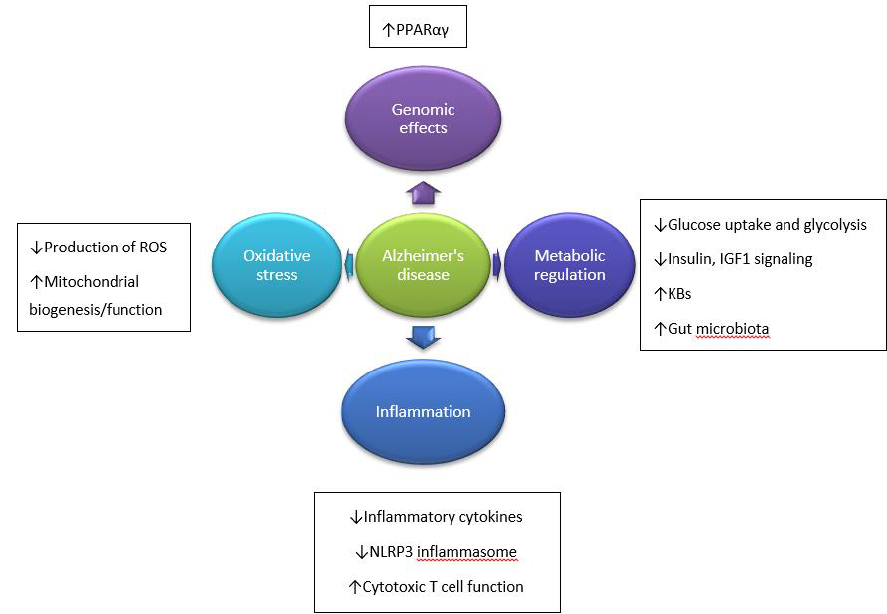
Figure 1. Hypothesized mechanisms through which ketogenic diet (KD) influence Alzheimer’s disease (AD) development. ↓ —decreased; ↑ —increased. Based on Reference [7].